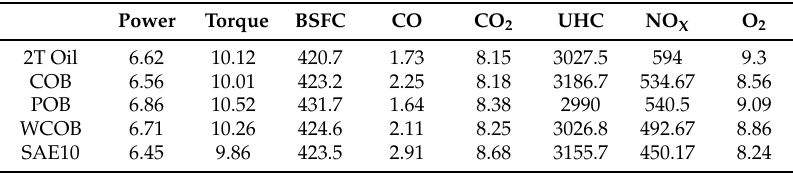
Table 5. Decision ‐ making matrix. Table 5. Decision-making matrix.